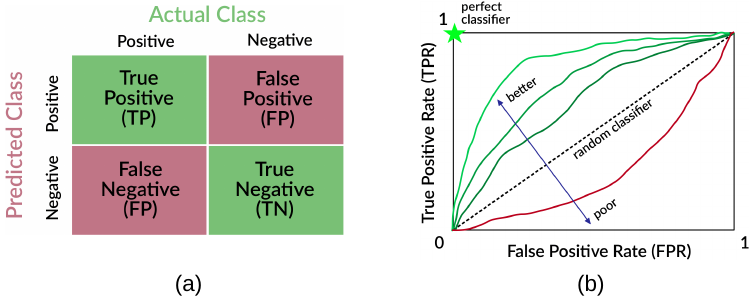
Figure 2. Pictorial illustration of ( a ) sequence partition according to classifier outcome; ( b ) different examples of ROC